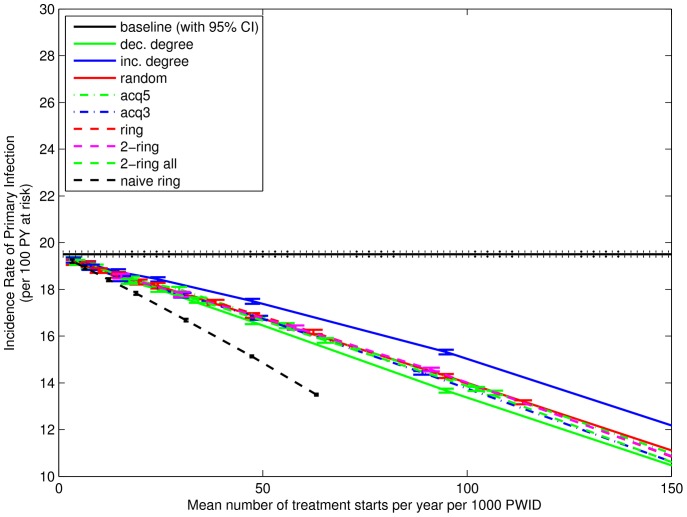
Incidence Rate of Primary Infection for Weeks 131–156.Vertical coordinate shows the mean incidence rate of primary infection in weeks 131–156, calculated as the mean incidence rates across 500 simulations and then the mean (with 95% confidence interval) across 100 networks. Horizontal coordinate shows the mean number of treatments started in weeks 1–156, calculated as the means across 500 simulations per network, then the mean across 100 networks, and then the mean across 3 years. Differences between strategies are smaller than for the incidence rate of total infection and re-infection. The “naive ring” strategy, which treats the primary contacts of randomly-chosen never infected nodes (if they exist) is quite effective. Mean treatment starts for “naive ring” are smaller because there are limited numbers of infected nodes available for treatment around randomly chosen uninfected nodes.